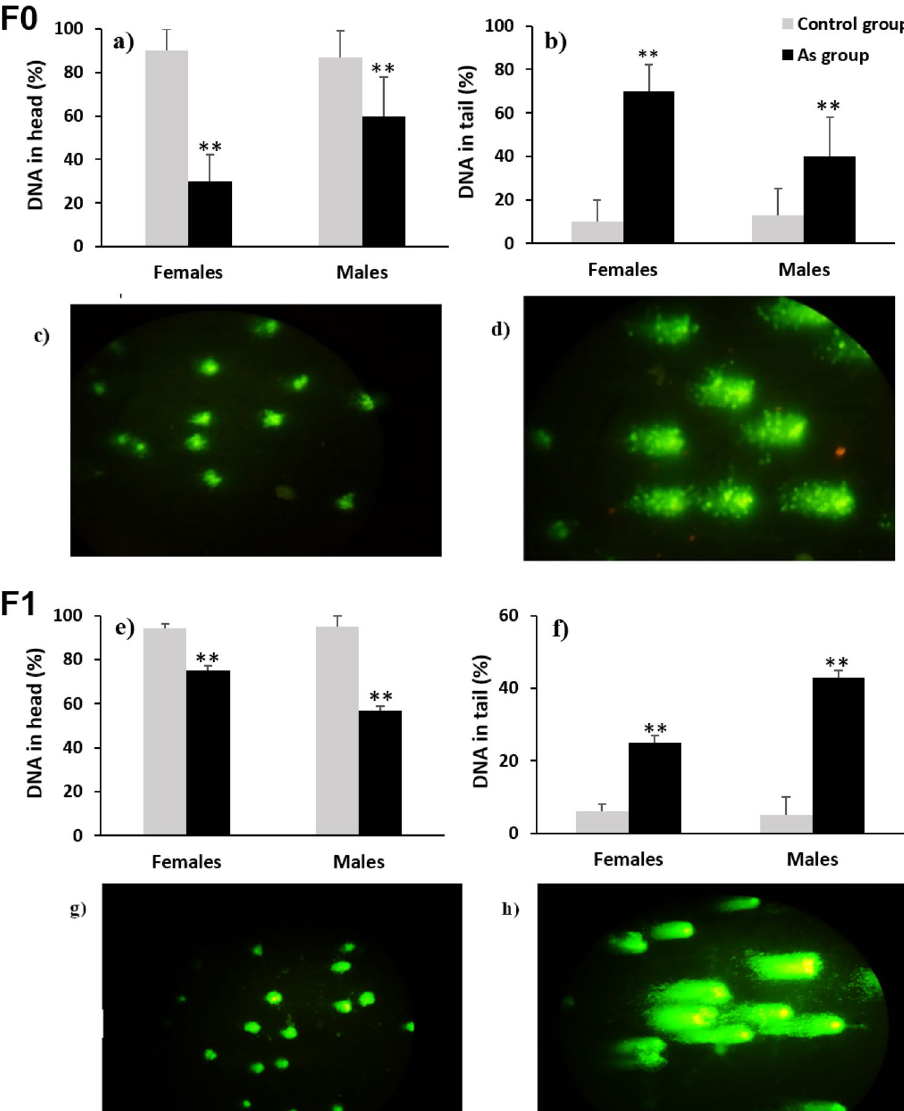
Figure 2. DNA damage in WBC assessed by comet assay (SCGE); ( a , e ) show the percentage of DNA in head (integrity) in males and females of the generations F0 (direct exposure) and F1 (partially exposed offspring) respectively; ( b , f ) show the percentage of the DNA in tail (fragmentation) in males and females of generations F0 and F1 respectively. Grey bars: control group and linage (n = 24), black bars: As exposed group and linage (n = 24). (*), (**) statistically significant differences intra-gender between control and arsenic exposed group in each generation at p < 0.05 and p < 0.01 respectively. Error bars: standard deviation. ( c , g ) microphotographs of WBC without fragmentation (F0 and F1, respectively); ( d , h ) microphotographs of WBC with fragmentation (F0 and F1